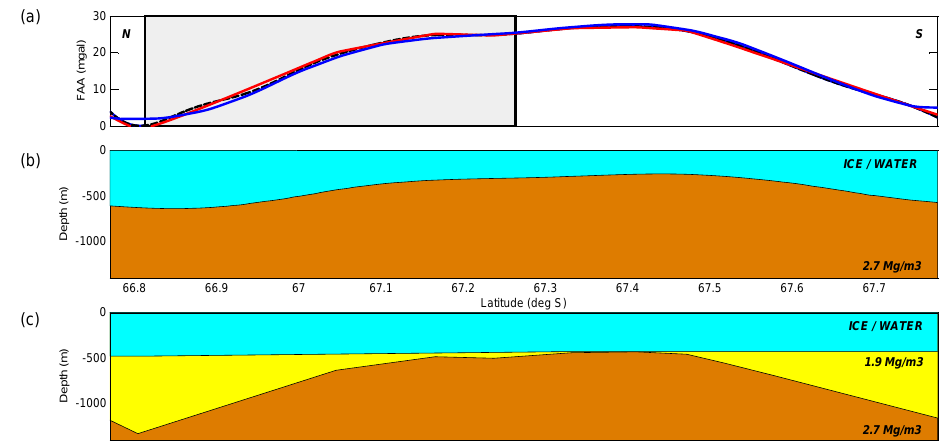
Fig. 7. Modelling of the IceBridge free-air gravity anomaly using the method of Talwani et al. (1959): (a) Black dashed line: measured IceBridge FAA; Blue line: modelled FAA with Cochran and Bell (2012) bathymetry model and constant sub-surface density of 2.7Mgm − 3 ; Red line: modelled FAA assuming 1.9Mgm − 3 sediment over 2.7Mgm − 3 basement and bathymetry as derived by seismic survey (seabed assumed laterally invariant south of last shot point). The length of the IceBridge line coincident with the seismic line is outlined by the grey box (i.e., where bathymetry is constrained by seismic measurements); (b) Cochran and Bell (2012) bathymetry from FAA inversion; (c) Simple 2-D model of sediment infill along the IceBridge flight